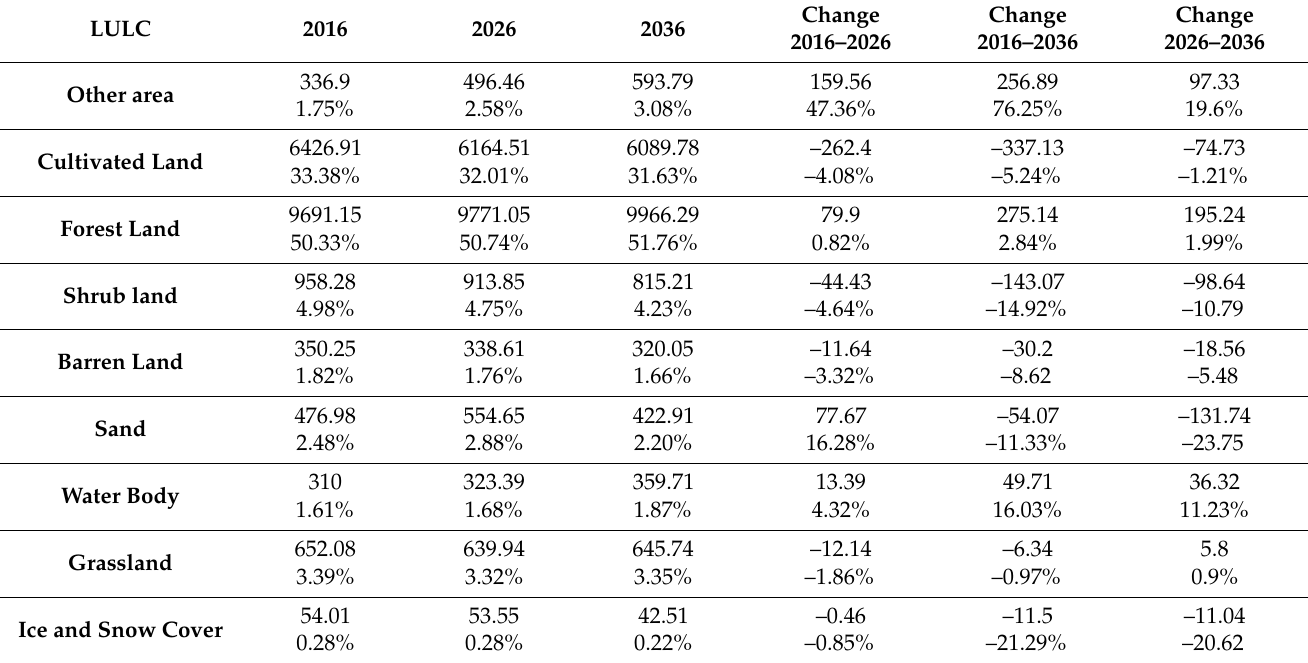
Table 7. LULC change of the study area during 2016–2036 (in km 2 and